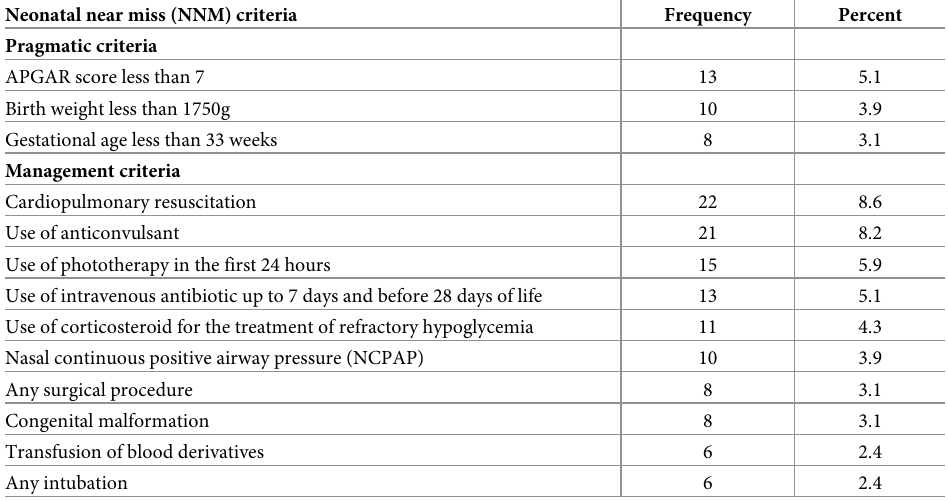
Table 3. Distribution of neonatal near miss conditions among neonates delivered in selected public hospitals of Jimma zone, southwest Ethiopia, 2020 (n = 255). Neonatal near miss (NNM)